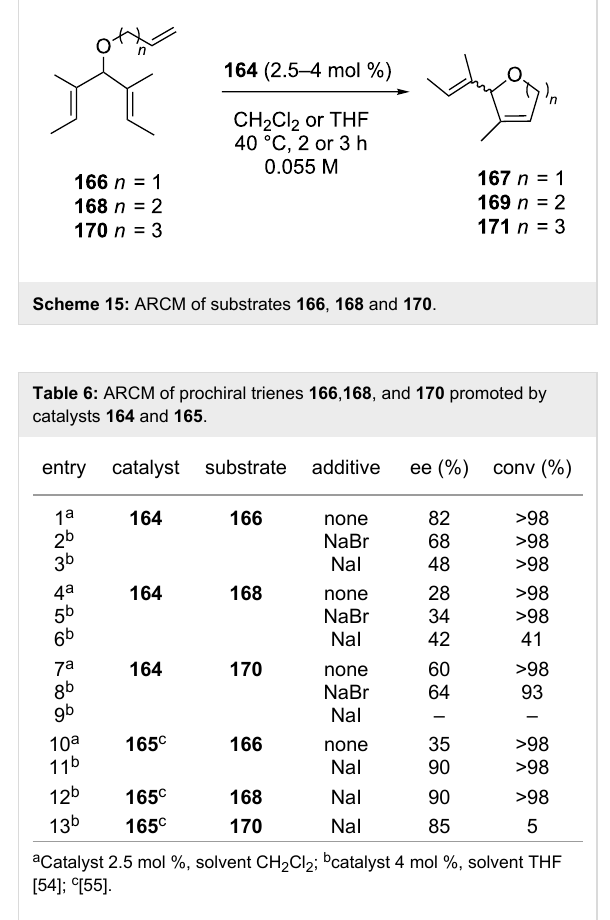
In order to try suppressing the NHC rotation during the